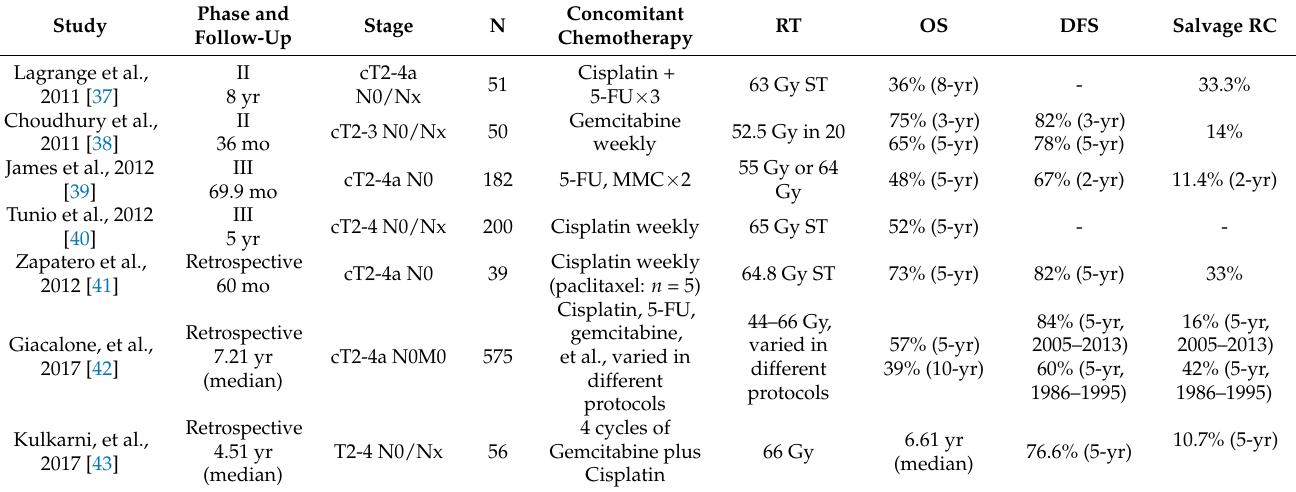
Table 1. Treatment Outcomes for Trimodal Therapies (TMT) published after